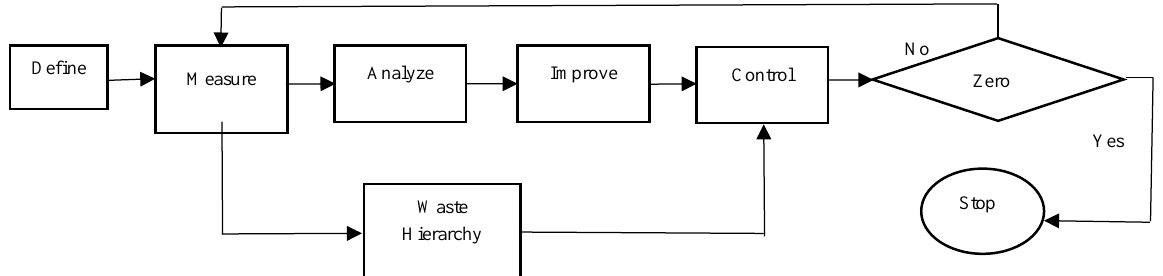
Figure 2. A general DMAIC food waste hierarchy integrated framework for food catering